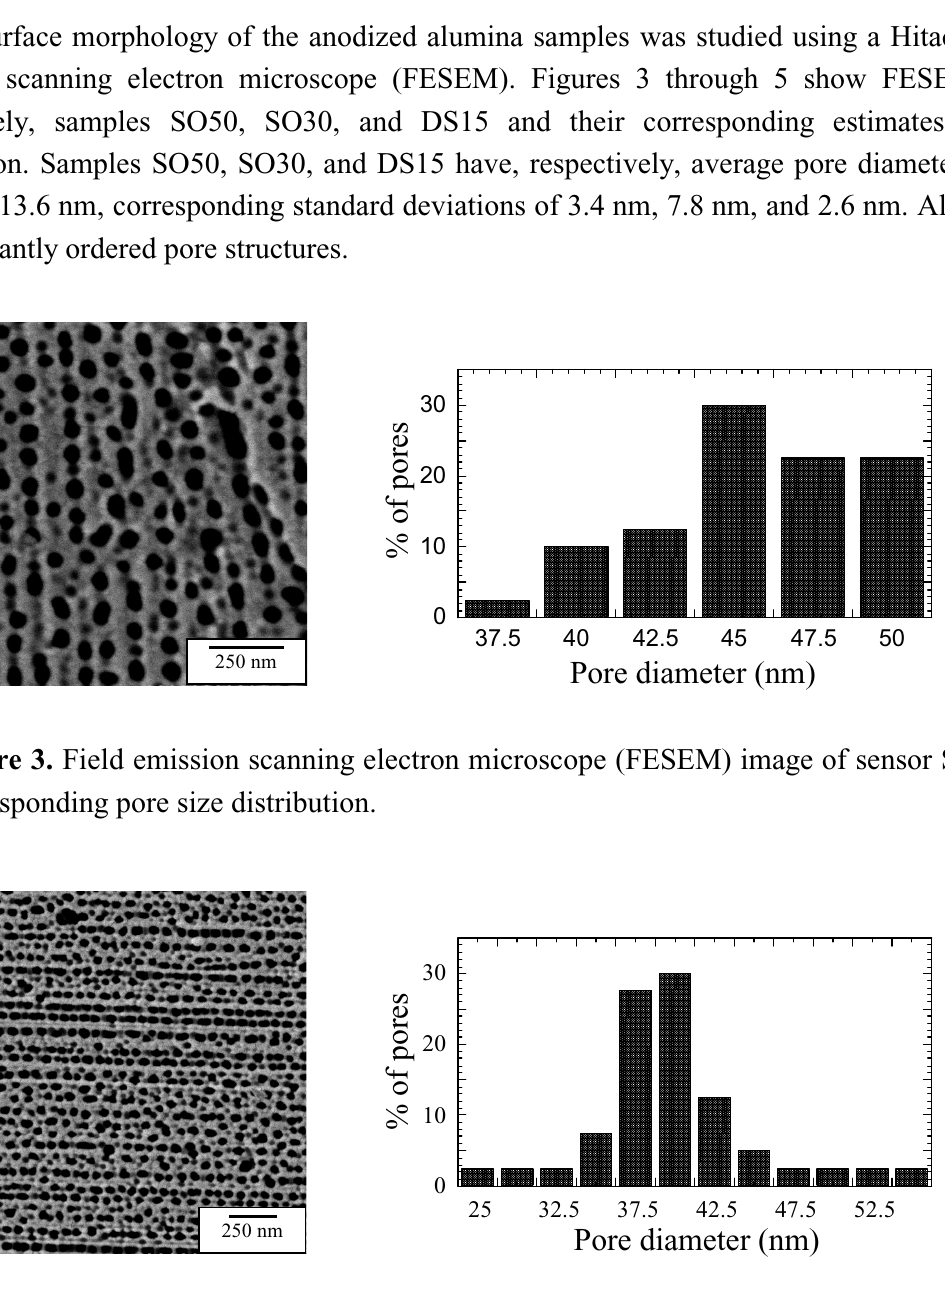
Figure 4. Field emission scanning electron microscope (FESEM) image of sensor SO30 with corresponding pore size